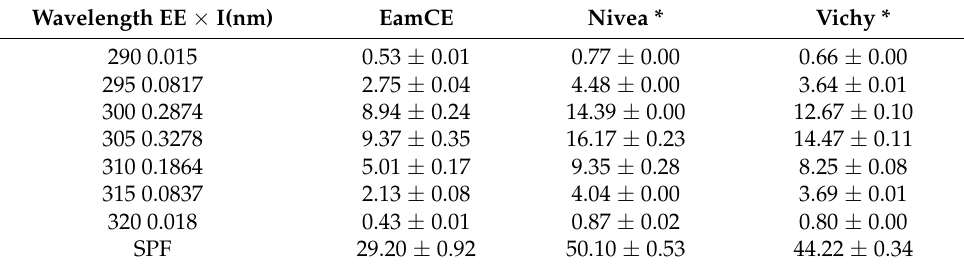
Table 5. The EamCE photoprotective activity.